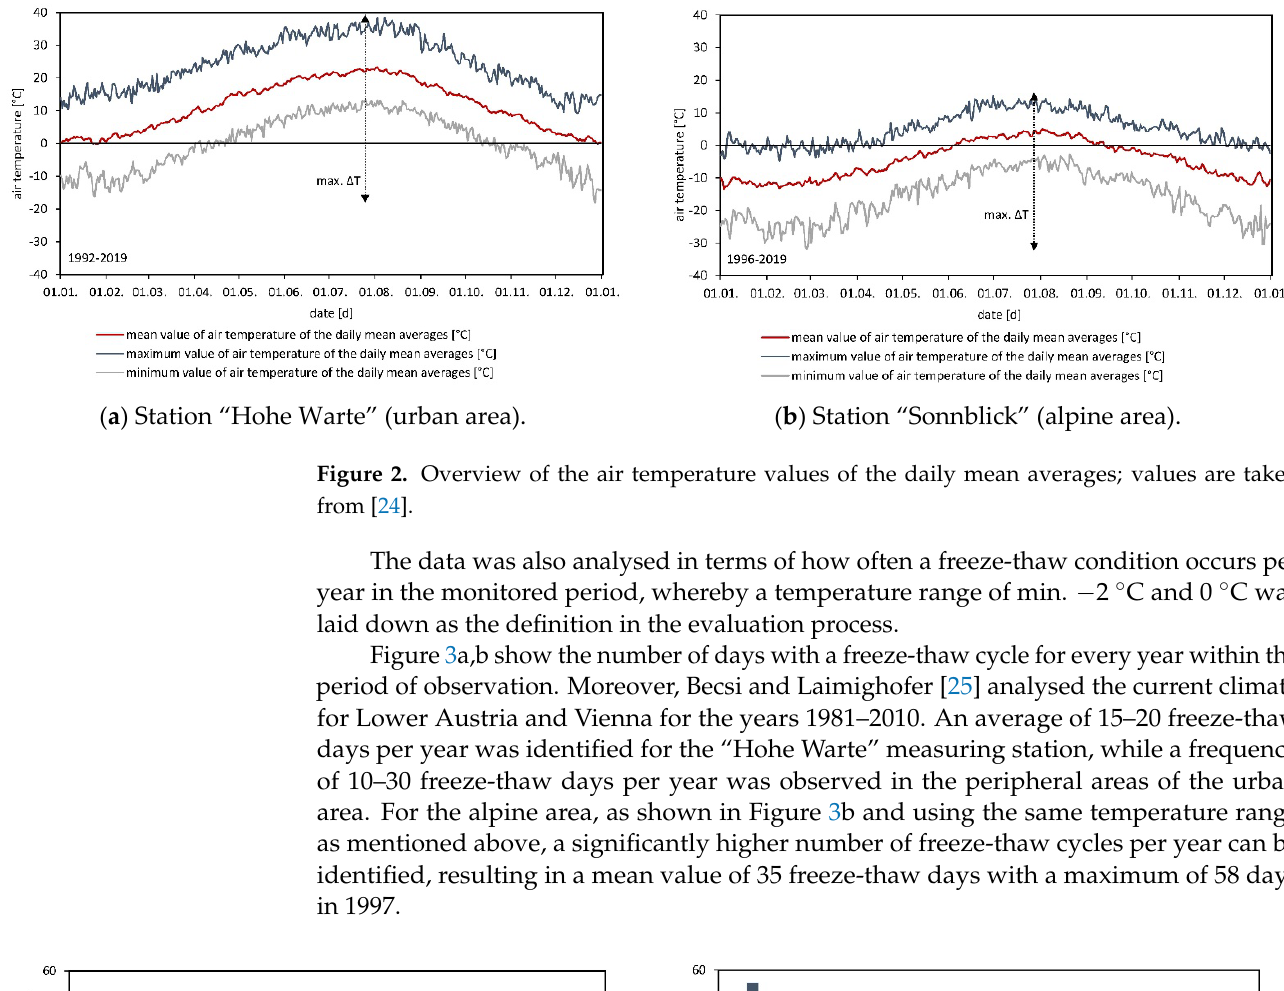
Figure 2. Overview of the air temperature values of the daily mean averages; values are taken from [24].